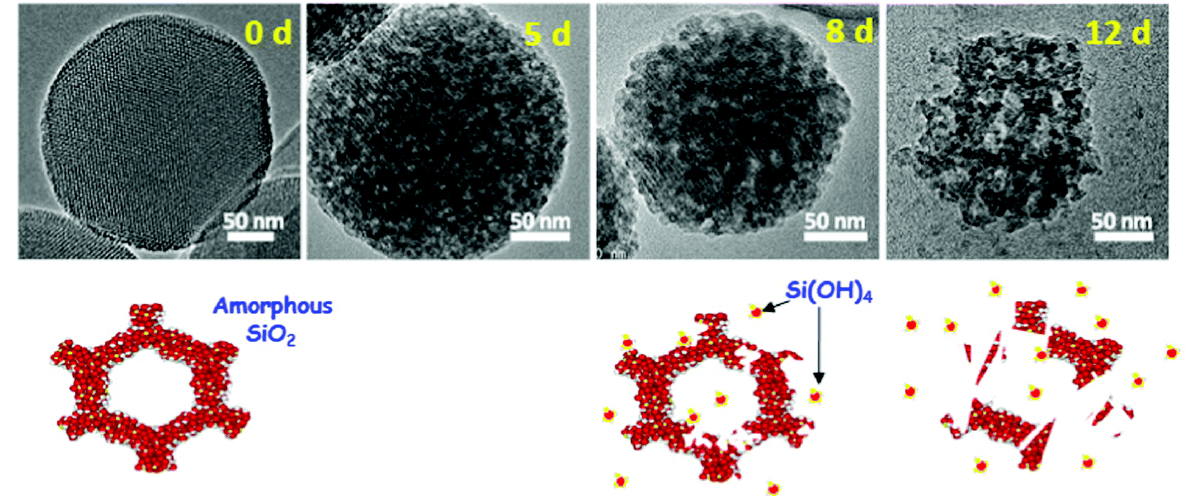
Figure 10. TEM images showing MSN degradation in PBS after 0, 5, 8 and 12 days, and schematic representation of their dissolution process in an aqueous medium. Reproduced from [17]. Under CC BY 3.0 license (https://creativecommons.org/licenses/by/3.0/, accessed on 27 November 2022).